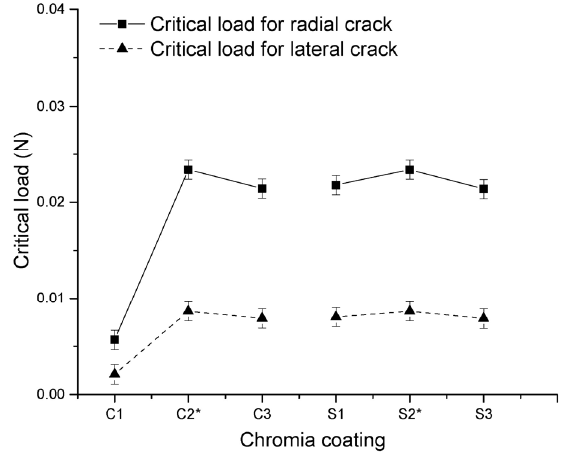
Fig. 7 Variation of critical load with respect to parameters of chromia